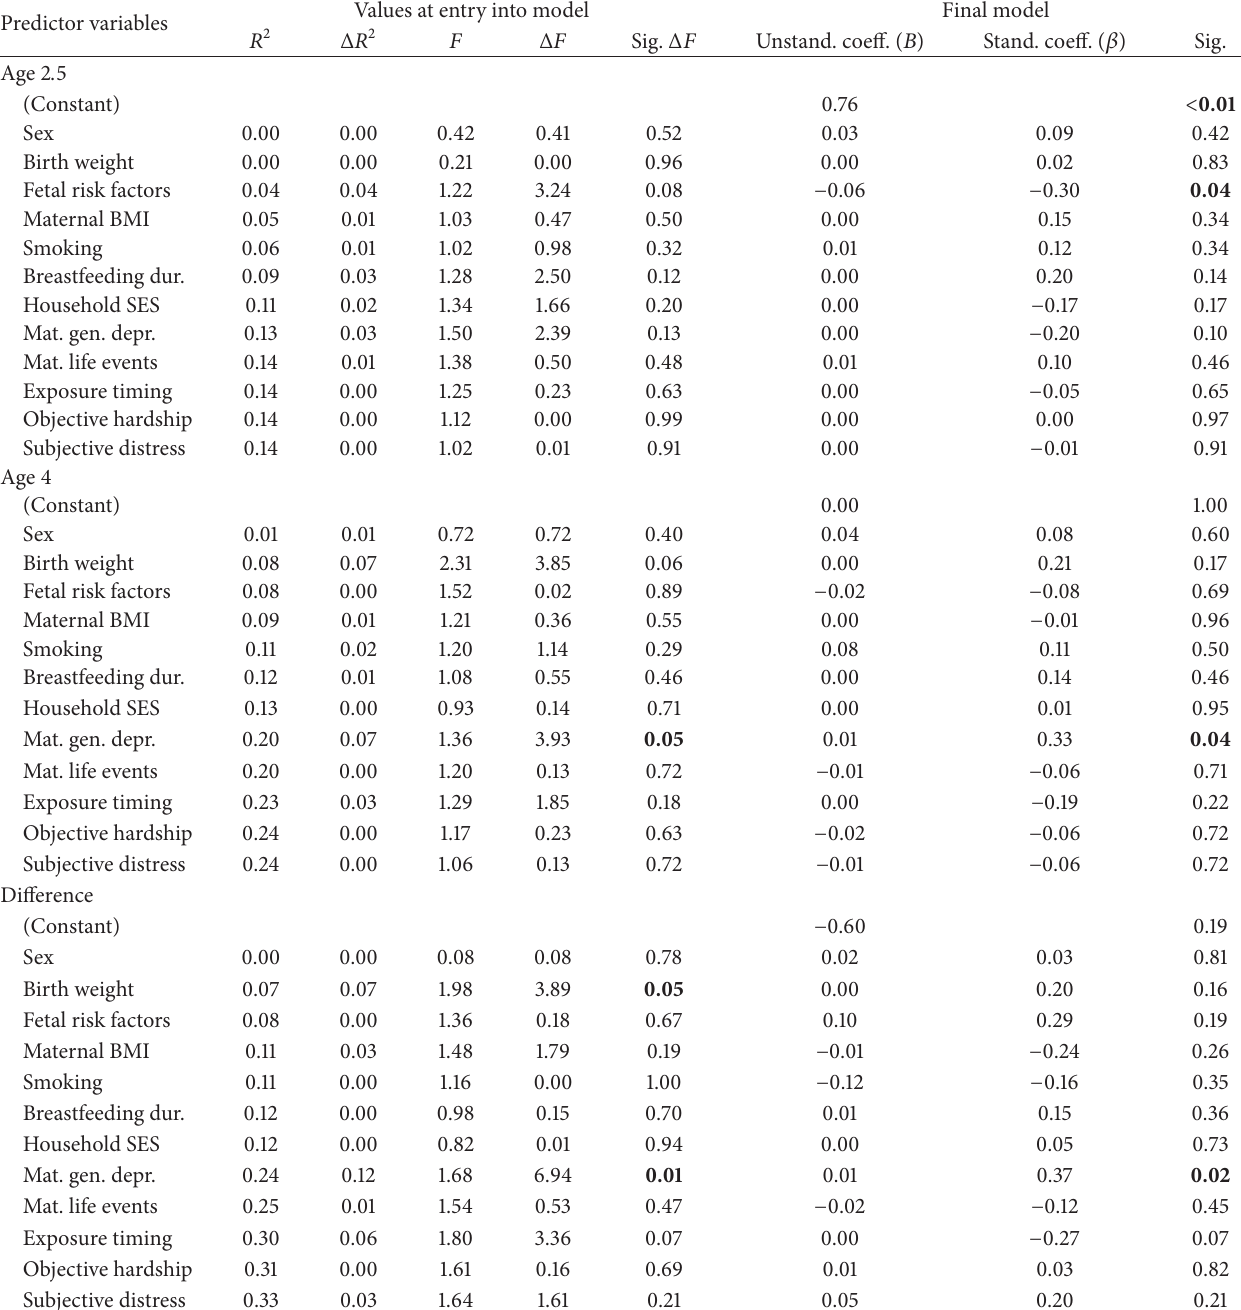
Table 4: Summary of hierarchical linear regression analyses for central adiposity (SS : TR). Significant effects are indicated in bold. Predictor